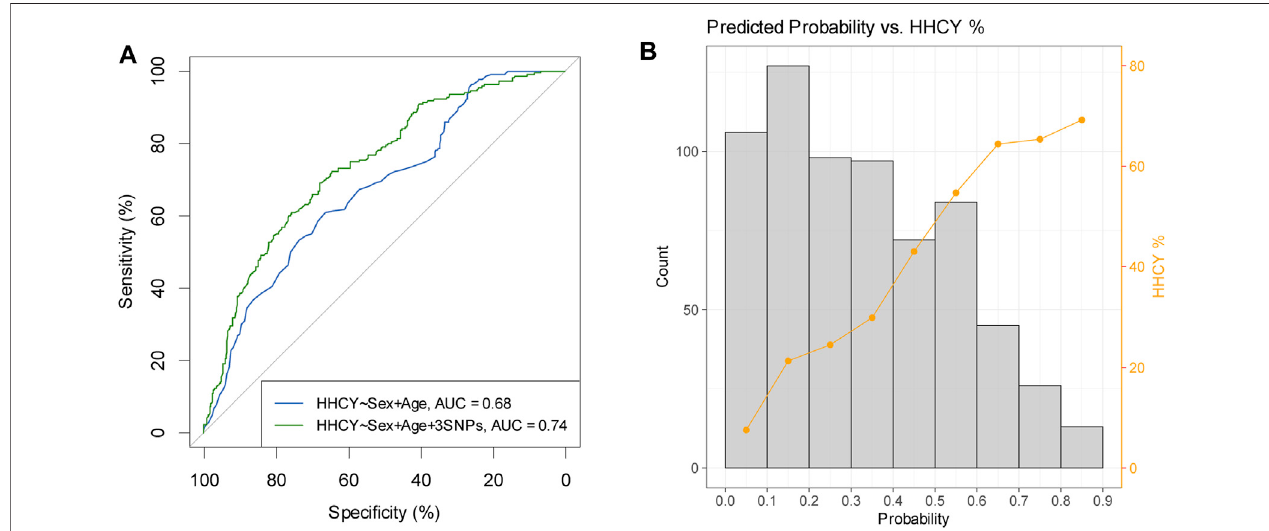
FIGURE 5 | Prediction results of HHCY prediction in replication samples (N (cid:1) 668). (A) Receiver operating characteristic curves for predicting HHCY status of prediction models considering sex and age as predictors with three identi fi ed SNPs (green line) or without three identi fi ed SNPs (blue line). (B) Histogram of predicted probability overplayed with percentage of HHCY in each probability bin (prediction model based on sex, age, and three identi fi ed variants as predictors). HHCY, hyperhomocysteinemia; SNP, single-nucleotide polymorphism.